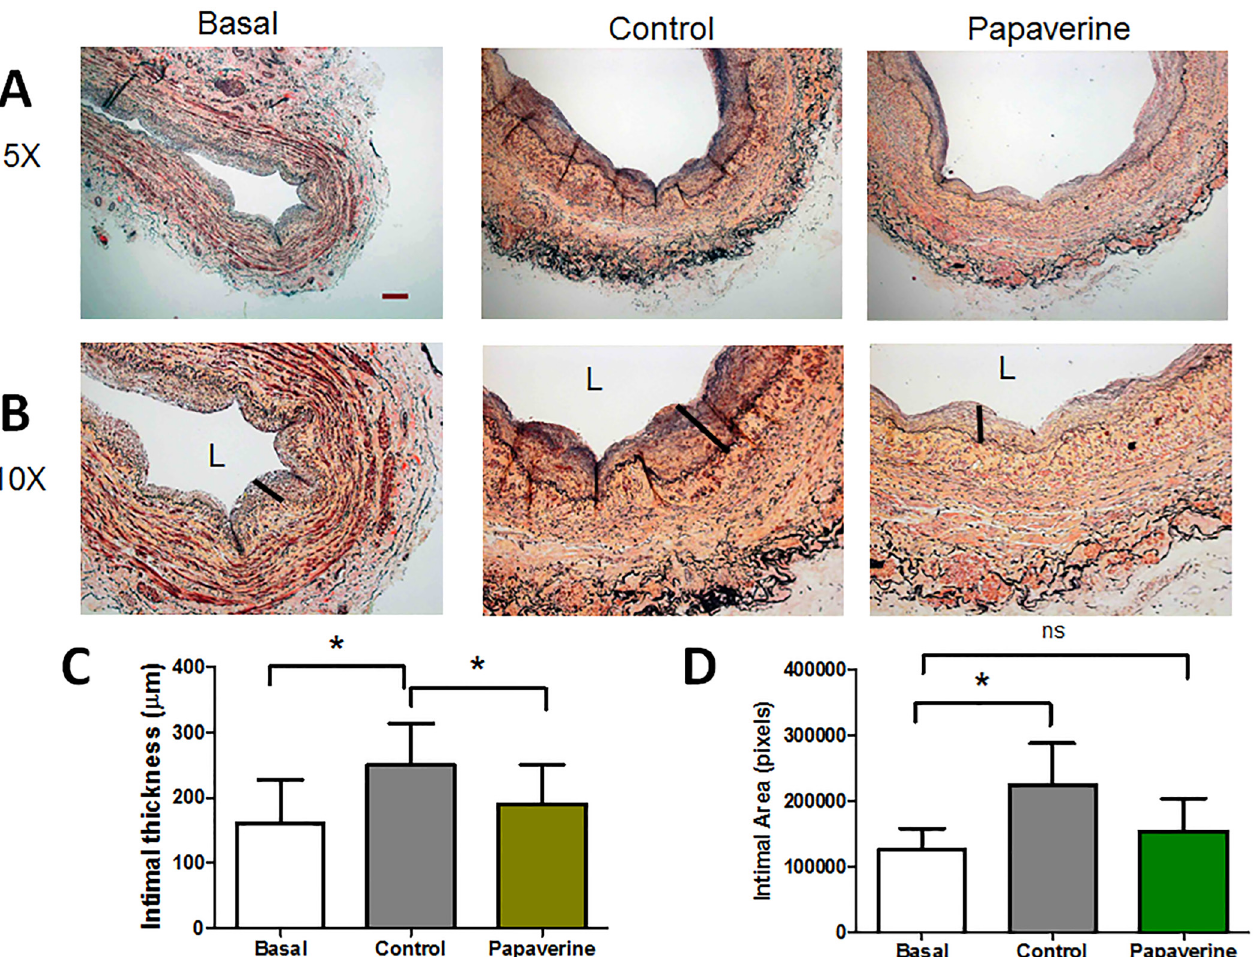
Fig 6. Papaverine pretreatment for 2 hrs prior to organ culture attenuated intimal thickening in HSV. HSV were fixed at day 0 for preculture (basal) conditions and then at 14 days with either control treatment or pretreatment with 1 mM papaverine for 2 hrs. Tissue was fixed after 14 days of organ culture and the intimal thickness was measured. Representative staining shown in 5 x magnification are shown in Panel A, with 10 x magnification shown in Panel B. Black line indicates the intimal thickening. The cumulative quantification of intimal thickness is displayed in Panel C. * Significant compared to control, (N = 4), p < 0.05 The area of the thickness was measured using Matlab software and the cumulative data is shown in Panel D. * Significant compared to control, N = 4, p <